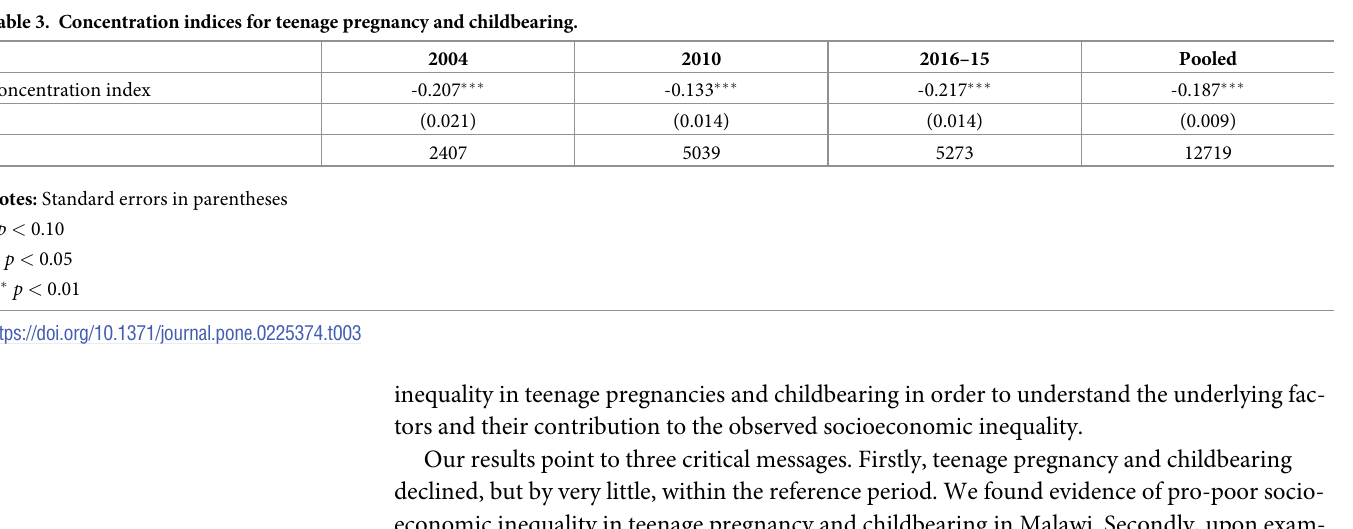
PLOS ONE | https://doi.org/10.1371/journal.pone.0225374 November20,